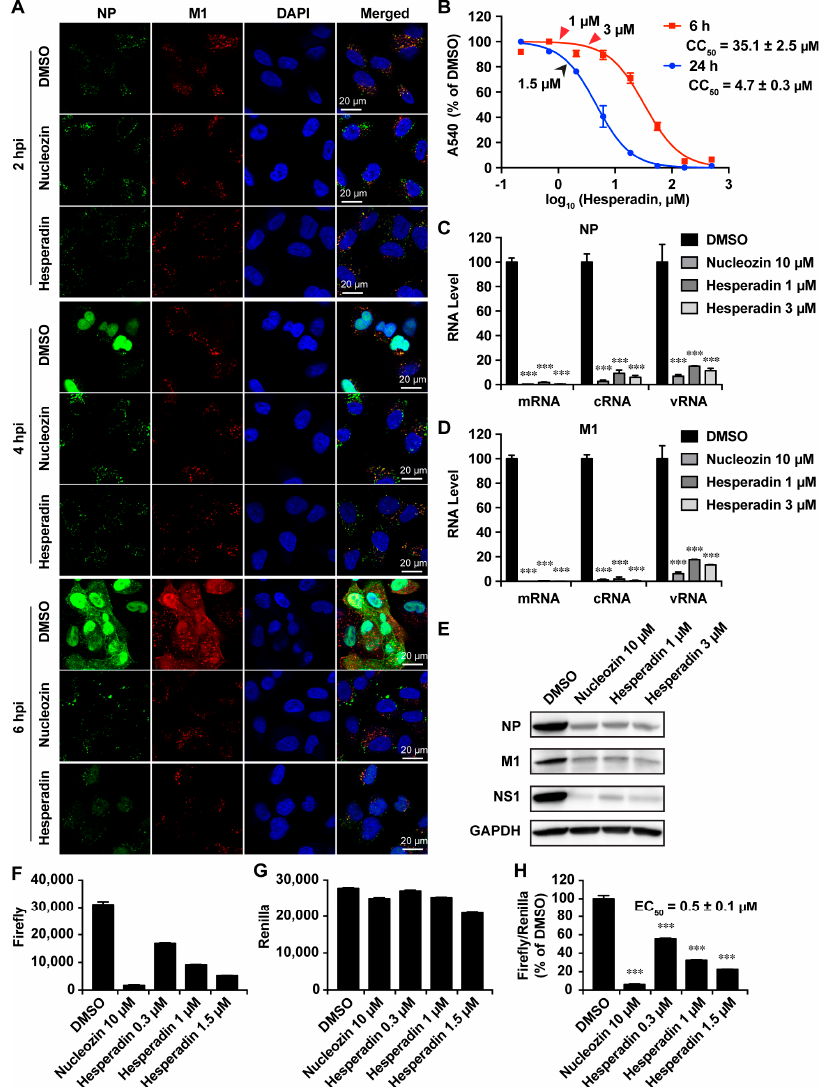
Figure 5. Hesperadin-inhibited viral replication via inhibition of vRNP nuclear entry. ( A ) Hesperadin delayed the vRNP nuclear entry. A549 cells infected with the A/WSN/33 (H1N1) virus (MOI = 30) were treated with DMSO, 10 µM of nucleozin or 1 µM of hesperadin. After fixation at indicated times (2, 4, and 6 h p.i.), cells were stained with mouse anti-influenza A NP antibody, rabbit anti-M1 antibody, and DAPI to determine the viral NP, M1 protein, and nucleus, respectively; ( B ) Cell viability of A549 cells when treated with hesperadin for 6 or 24 h. The arrows indicate the concentrations used (Red arrows: ( C – E ); Black arrows: ( F – H ). The CC 50 value represent the average of eight repeats ± standard deviation; ( C – E ) Hesperadin reduced the levels of viral RNAs and proteins. A549 cells infected with the A/WSN/33 (H1N1) virus (MOI = 1) were treated with DMSO, 10 µM of nucleozin, 1 or 3 µM of hesperadin, respectively. At 6 h p.i., cells were harvested and total viral RNAs or proteins were extracted. The mRNA, cRNA and vRNA of NP and M1 were quantified by RT-qPCR ( C , D ); Viral protein NP, M1 and NS1 were examined by western blot ( E ); ( F – H ) Mini-genome assay. A549 cells were transfected with a combination of plasmids for mini-genome assay (see Materials and Methods). Hesperadin was added to the culture medium at 2 h post transfection. At 24 h post transfection, cells were harvested for measurement of Firefly ( F ) and Renilla ( G ) luciferase activities. Renilla served as an internal control to normalize the transfection efficacy ( H ). Asterisks indicate statistically significant difference in comparison with the DMSO control (student’s t -test, *** p < 0.001). The results represent the average of two repeats ± standard deviation.